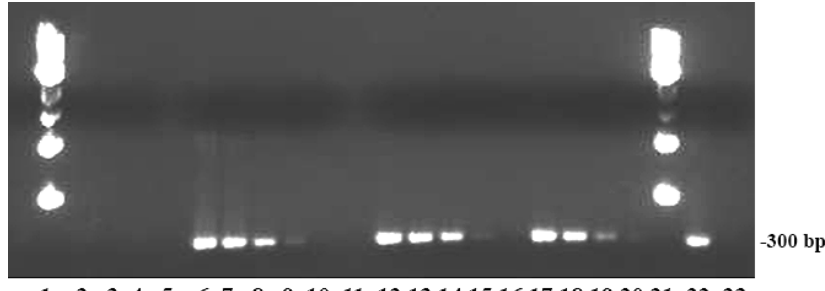
Figure 3. PCR amplicons from Brucella and control strains. Lanes and lysates representing the number of cells from nomenspecies used for PCR: 1 and 21, molecular size standards; 5 and 11, blank wells; 2–4, 3 × 10 7 , 3 × 10 5 , and 3 × 10 3 cells of Pseudomonas aeruginosa (the same negative results for the same number of cells are not shown for Escherichia coli and Salmonella Typhimurium); 6–10, 8 × 10 6 , 8 × 10 5 , 8 × 10 4 , 8 × 10 3 , and 8 × 10 2 cells of B. abortus ; 12–16, 6 × 10 6 , 6 × 10 5 , 6 × 10 4 , 6 × 10 3 , and 6 × 10 2 cells of B. suis ; 17–20, 5 × 10 6 , 5 × 10 5 , 5 × 10 4 , and 5 × 10 3 cells of B. melitensis ; 22, positive control (26 ng of B.